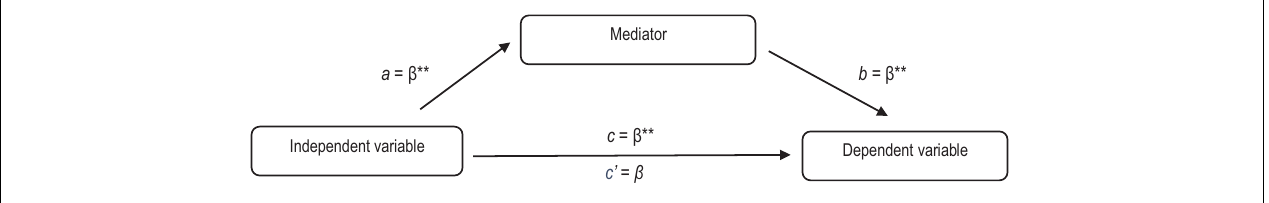
TABLE 1 | Family functioning and dimensions of self-esteem in the control group (without an increased risk for ED) and the study group (wih an increased risk for ED). Control group ( n = 86) Study group ( n = 74) M SD M SD